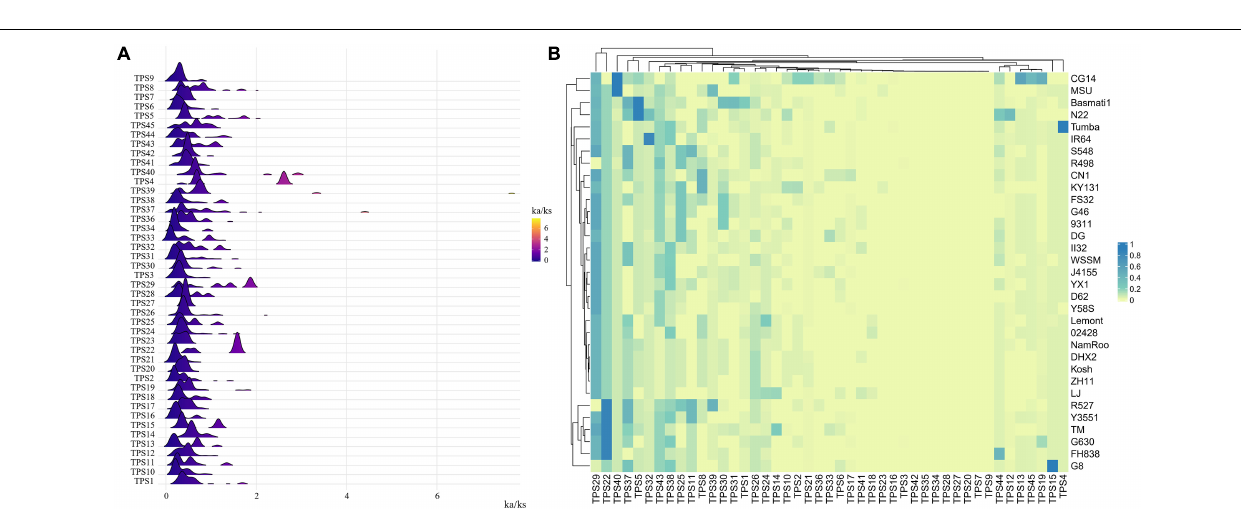
FIGURE 2 | The evolution of TPS in the 33 rice varieties. (A) Ridgeline plot of Ka/Ks ratios of each TPS in the 33 accessions. (B) Heatmap of the frequency of occurrence of different rice varieties at each TPS with Ka/Ks ratio >